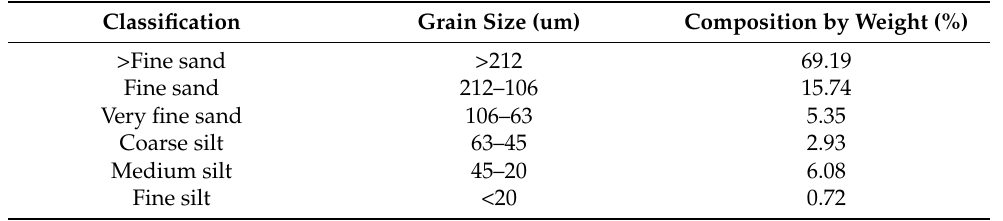
Table 1. Representative sediment classification, grain size, and composition for Hecate Strait. Infor- mation is derived from [5]. Note that there are slight differences between our composition percentage values and theirs because we use the sum of the component weights instead of the total weight provided in